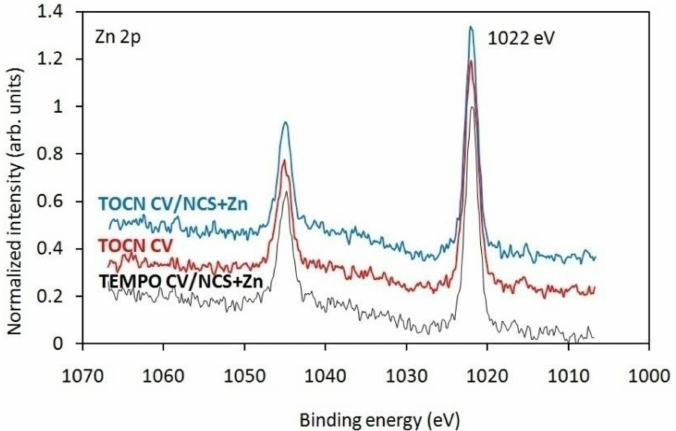
Figure 2. High-resolution spectra of NCS + Zn functionalized pristine and pre-treated viscose fabrics. Elemental surface compositions of the pristine and pre-treated viscose fabrics before and after functionalization with NCS + Zn determined by XPS are presented in Table 2. The highest atomic percentage of N and Zn was obtained for NCS + Zn functionalized TEMPO-oxidized viscose fabric (sample TEMPO CV/NCS + Zn), while similar values were obtained for NCS + Zn functionalized pristine (sample CV/NCS + Zn) and TOCN-coated viscose (sample TOCN CV/NCS + Zn). Elements present at the trace level are impurities or residual chemicals from different functionalization